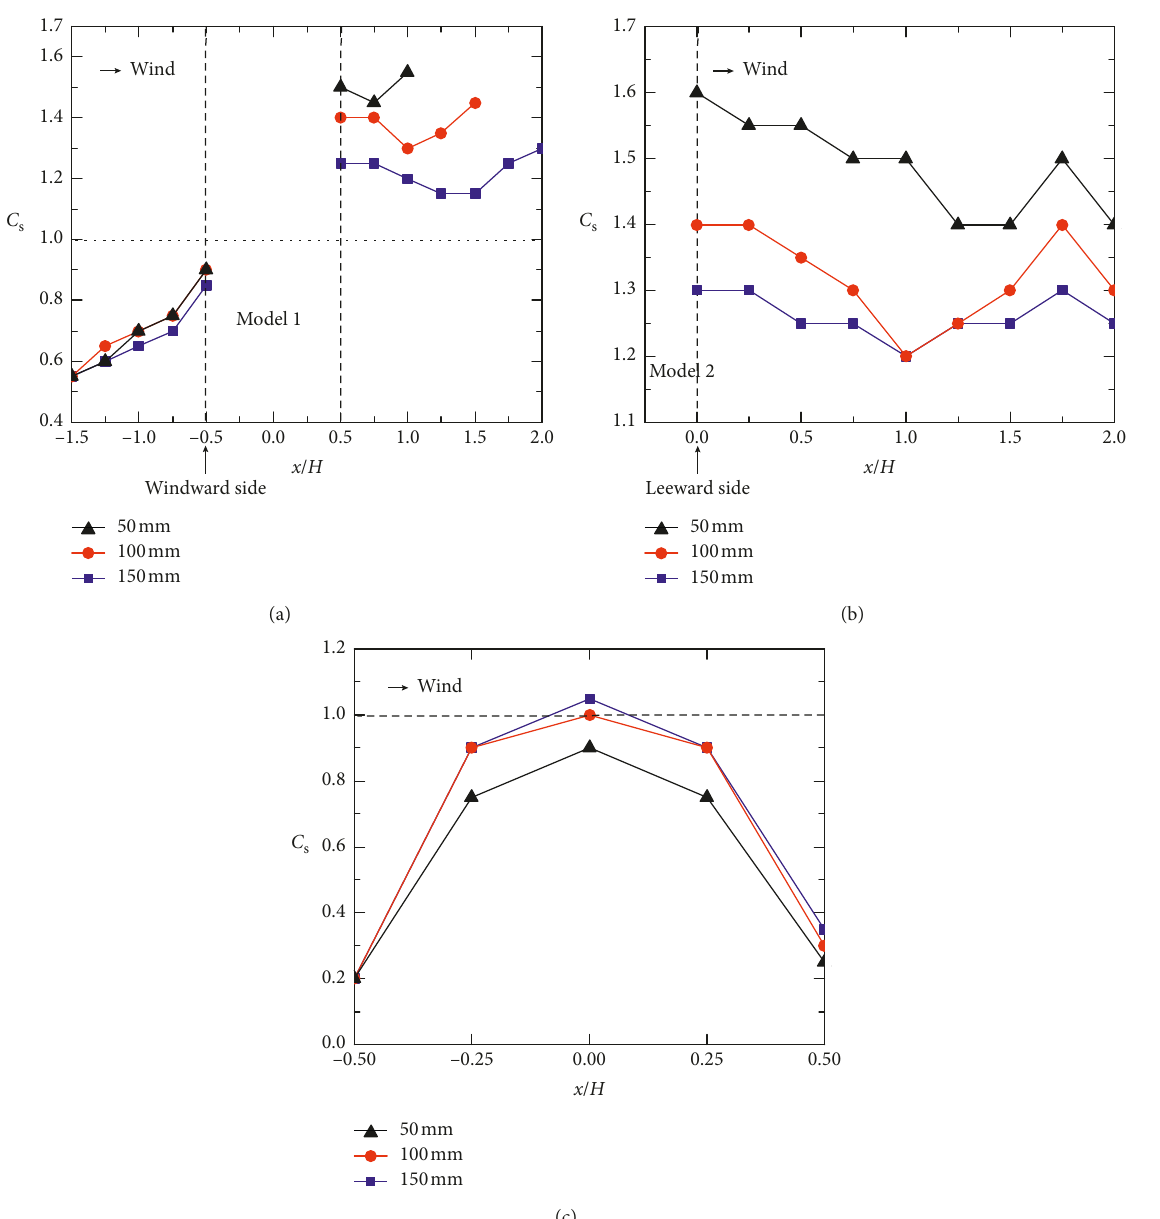
Figure 13: Snow distribution curves of (a) model 1 and (b) model 2 with different distances around their corresponding central axes and (c) surface area snow distribution of model